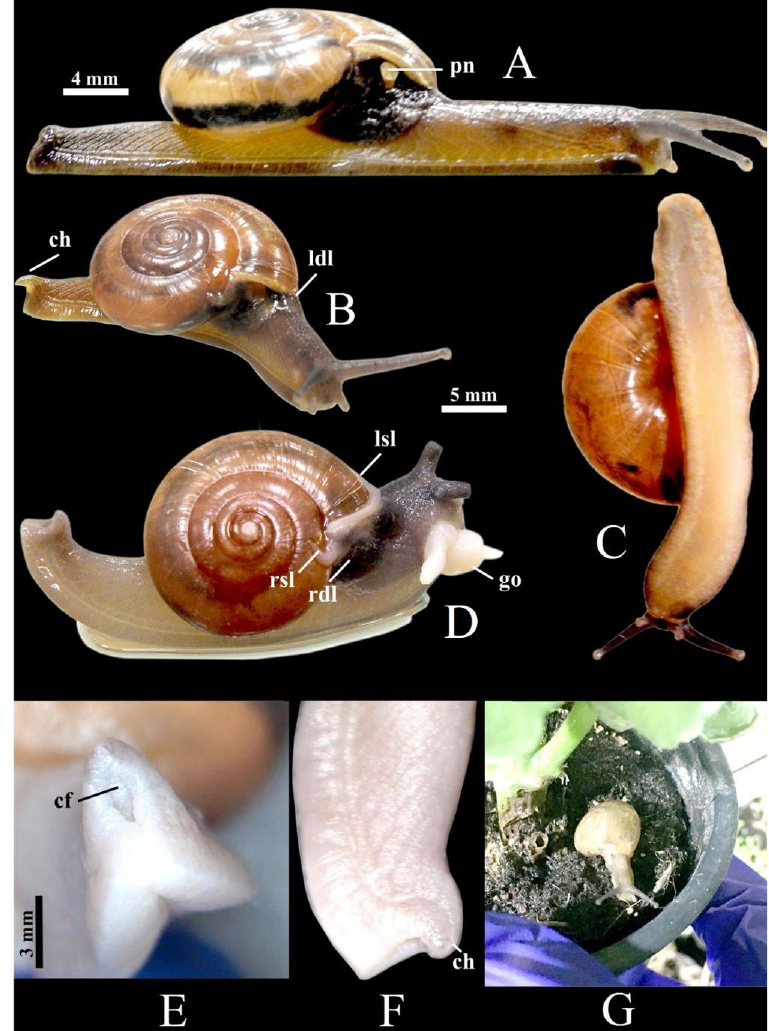
Figure 4. External morphology of Macrochlamys indica. ( A – C ) living snail collected from Al-Yosif nursery, Tabouk (( A ) lateral view; ( B ) dorsal view; ( C ) ventral view); ( D ) preserved snail collected from Magic Rose nursery, Tabouk; ( E ) caudal foss; ( F ) caudal horn; ( G ) living snail found on an ornamental plant in Al-Habry nursery, Riyadh. Abbreviations: cf, caudal foss; ch, caudal horn; go, genital organs; lsl, left shell lobe; ldl, left dorsal lobe; rdl, right dorsal lobe; rsl, right shell lobe; pn, pneumostome . Genital organs: the genital opening is on the right side of the head. The genital atrium (at) is a muscular structure elongated to some extent and is wider than the vagina (v) (Figure 5A). The vagina is found between the dart apparatus and the complex of the penial sheath. It opens into the genital atrium and hence the genital opening. The penis (p) is a muscular prolonged structure enclosed by a semi-transparent sheath (Figure 5A,E). The epiphallus (e) is a slender structure longer than the penis. The epiphallus has three distin- guished parts; the proximal epiphallus (pe), epiphallic caecum (ec), and distal epiphallus (de) (Figure 5A,D). The epiphallic caecum (ec) is a small circular sac. It is coiled for about two circles, located at one third the length of the epiphallus and attached with the penial